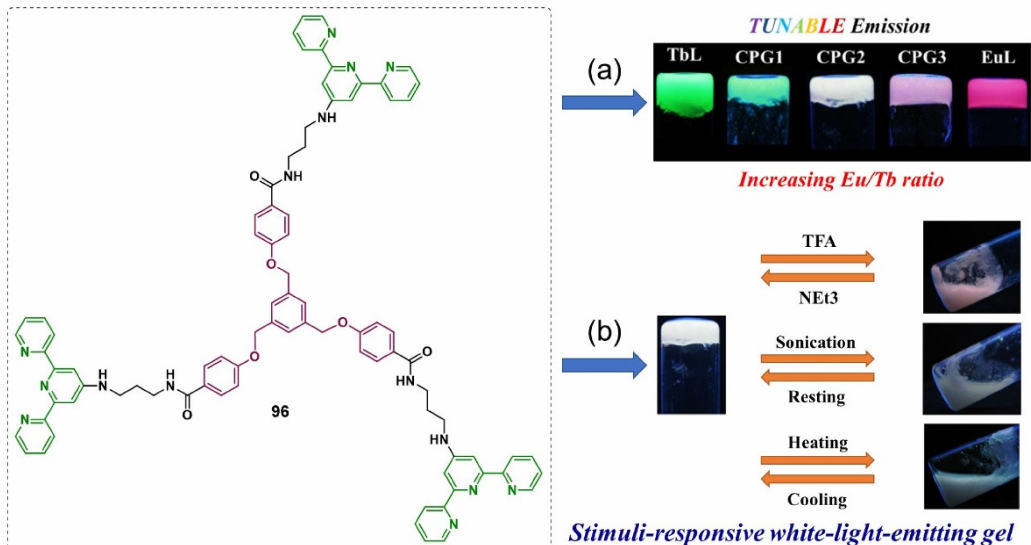
Figure 41. ( a ) Coordination of 96 with Tb III /Eu III (in different ratios) resulted in CPGs with tunable emission properties, including white-light emission. ( b ) The white-light-emitting CPG showed multi-stimuli-responsive behaviors. Reprinted with permission from Ref. [120]. Copyright (2017), American Chemical Society.